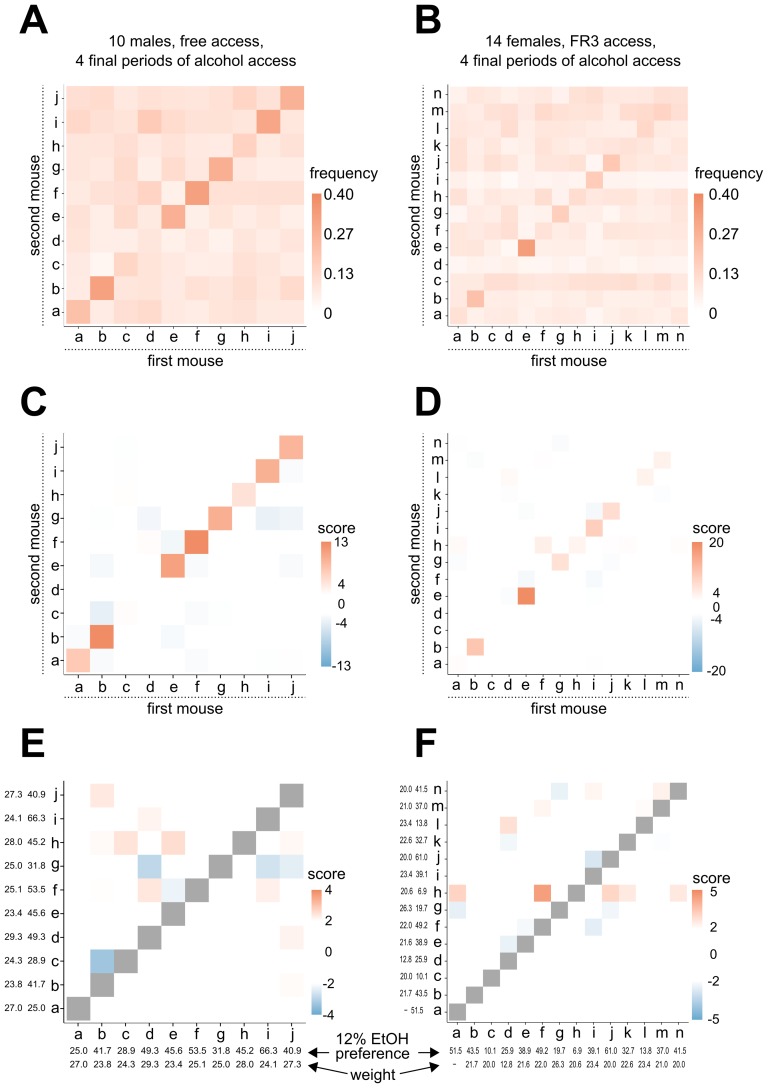
Social interactions of the mice.(A, B) Frequencies of sequences of entries into the corners. The heat maps show the relative frequencies of combinations of visits into the same corner by a pair of mice that occurred within the interval of 1 second to 1 minute. Each mouse was assigned an alphabet letter. On the maps, the first mouse in the sequence is indicated on the x-axis, and the second mouse is indicated on the y-axis; e.g., the bottom leftmost square corresponds to the frequencies of the ‘aa’ pairs. The intensity of the color is proportional to fraction of a specific pair among all pairs with the same first mouse (thus each column has a sum of 1). The intensity scales are indicated to the right of each heat maps. The data shown correspond to the last 4 intervals with alcohol access. Panel A shows data derived from 2972 pairs (filtered from 6548) and panel B represents 4643 pair sequences (filtered from 8573). (C, D) Interactions diverging from a random pattern. The heat maps show the relative statistical significances of pairs of entries (see Methods for the score calculation method). Only pairs with |scores| >2 are shaded. (E, F) Interactions diverging from a random pattern with repeats removed. The scores were calculated as in C and D, but they exclude all instances of the same mouse performing repeated entries (e.g., ‘bb’). The numbers shown near the axes are the alcohol preferences and animal weights. Only pairs with |scores| >2 are shaded.